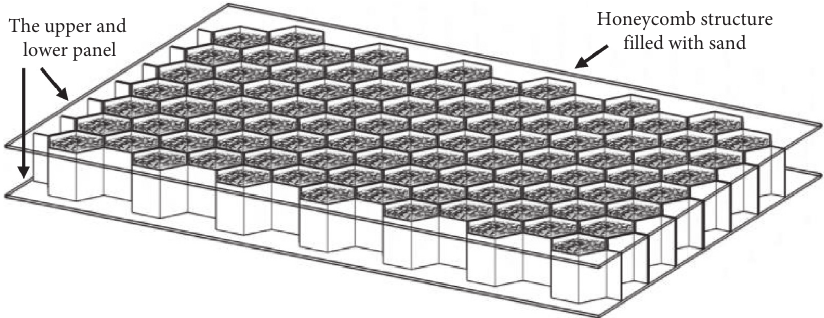
Figure 4: Schematic diagram of bearing layer.